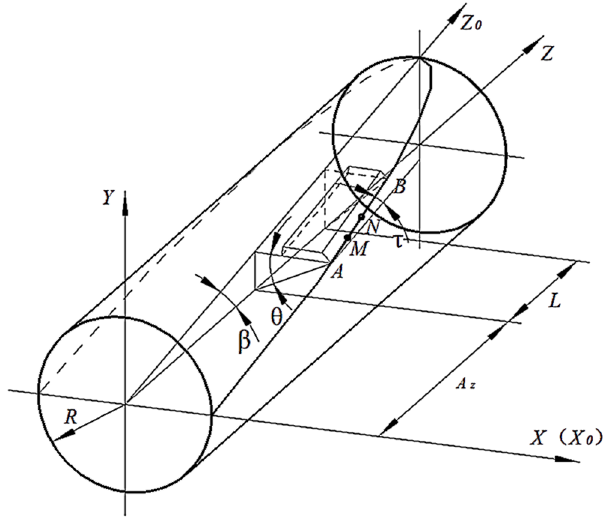
Figure 3. Structure parameters of blade on the chopper.